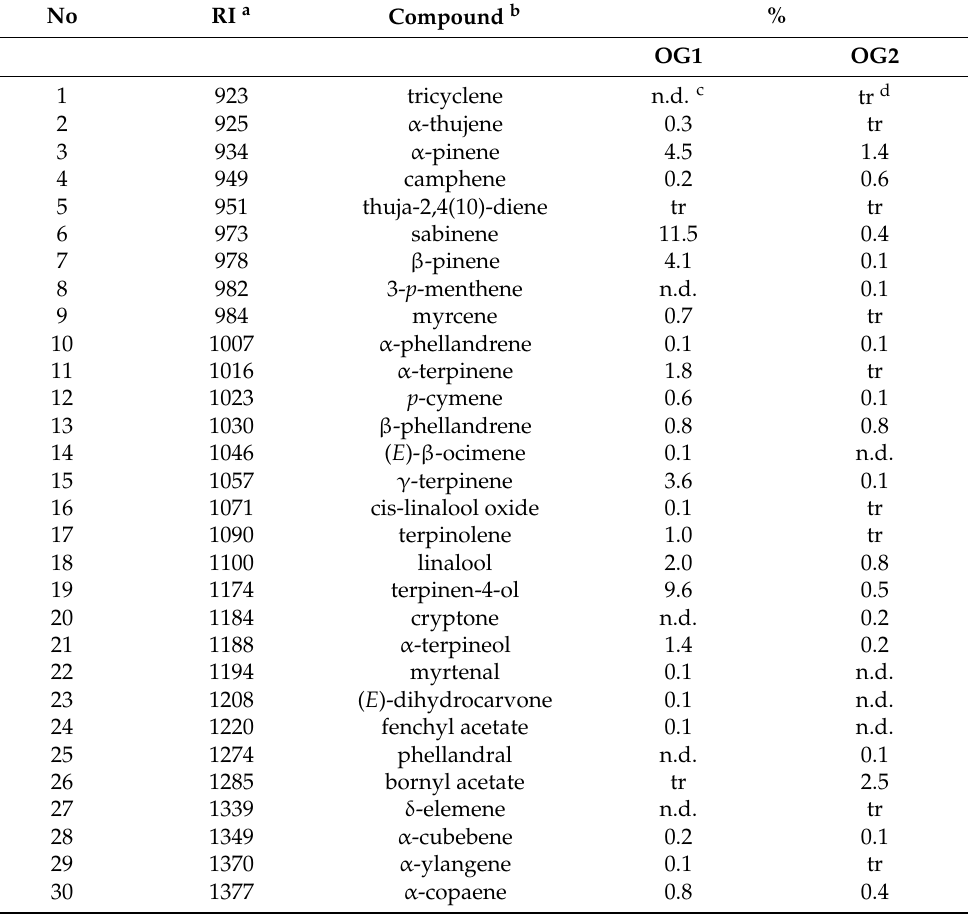
Table 1. Chemical composition of essential oils from aerial parts of O. grandiflora